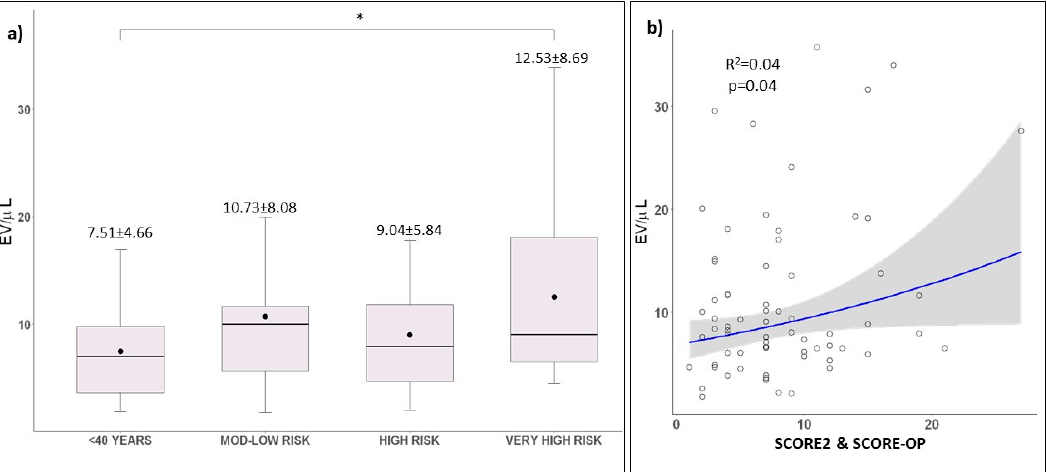
Figure 1. Extracellular vesicles and risk categories. ( a ) Boxplot of risk categories and EV (ANOVA; p = 0.04). Black dots represent the mean. Asterisks represent adjusted significant post hoc Tukey test between groups (* p < 0.05). Post hoc Tukey pairwise comparations: <40 years vs. low-to-moderate risk: p = 0.68, <40 years vs. high risk: p = 0.76, <40 years vs. very high risk: p = 0.03, low-to-moderate risk vs. high risk: p = 0.98, low-to-moderate risk vs. very high risk: p = 0.71, high risk vs. very high risk: p = 0.22. ( b ) Regression model of extracellular vesicles and SCORE2 and SCORE-OP ( p = 0.04). Blue line represents regression line of best fit. The grey bands around the line represent 95% confidence intervals.